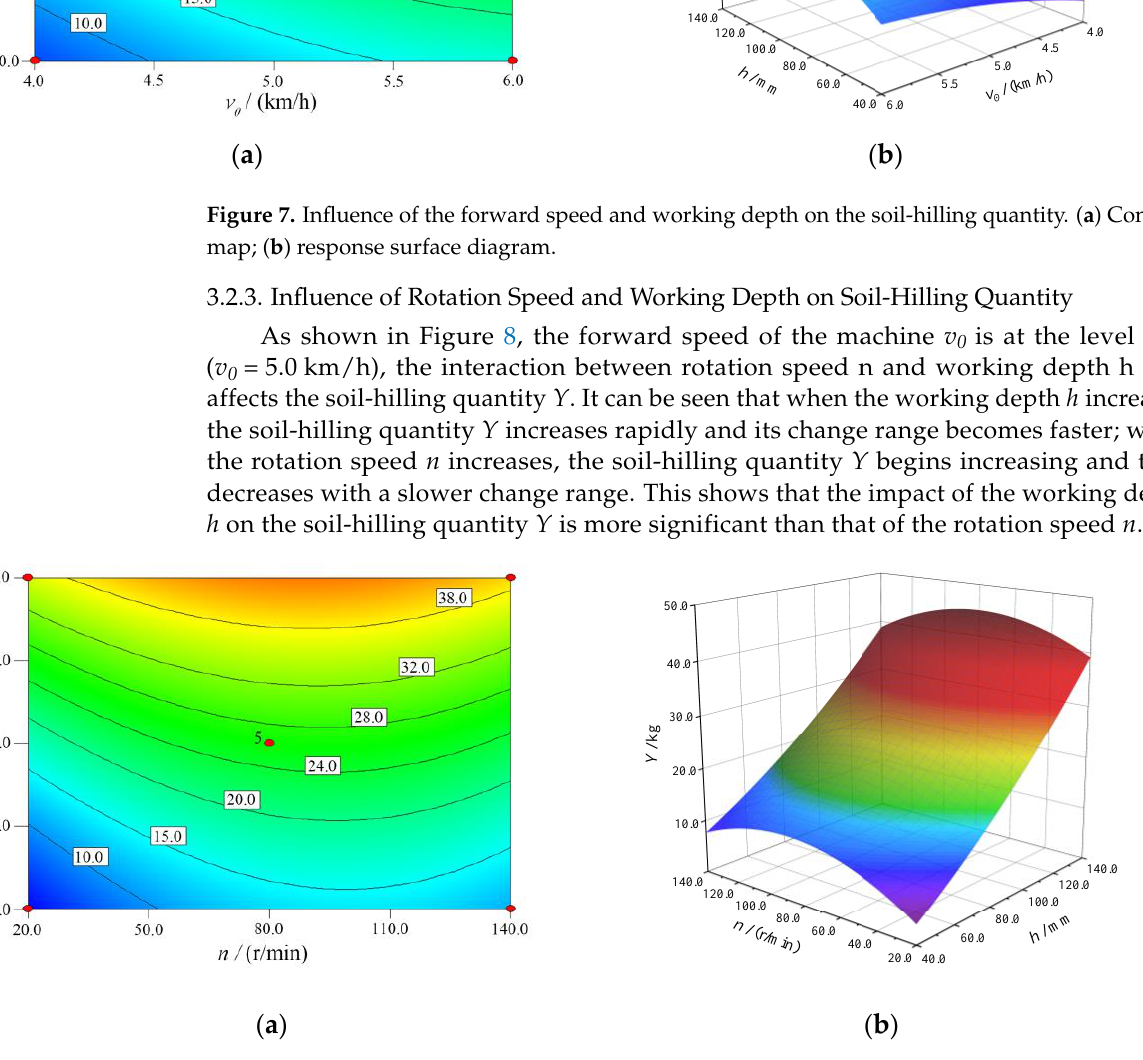
Figure 8. Influence of the forward speed and working depth on the soil-hilling quantity. ( a ) Contour map; ( b ) response surface diagram.